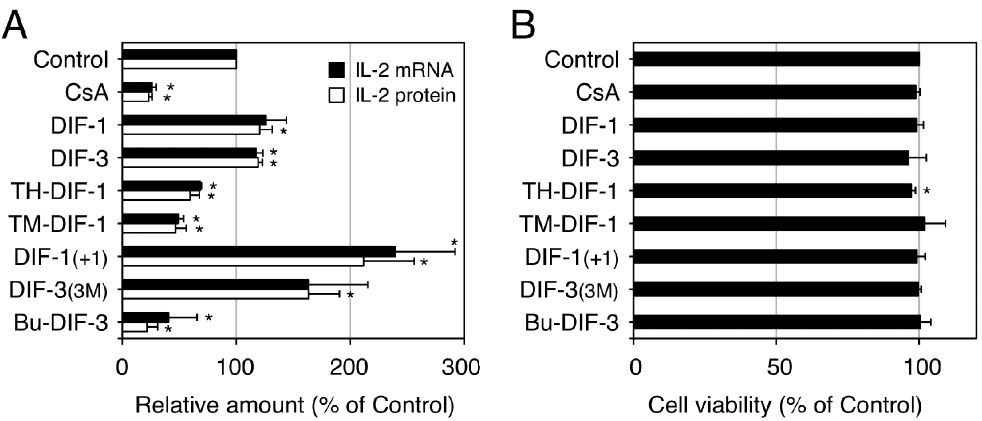
Figure 7. Effects of DIFs on ConA-induced IL-2 production in human Jurkat T cells. Jurkat T cells were pre-incubated at 37 ◦ C for 0.5 h in the presence of 0.1% EtOH (vehicle; Control), 1 µ M cyclosporin A (CsA), or 5 µ M of one of the DIF derivatives. After the addition of ConA (as a mitogen), the cells were further incubated at 37 ◦ C for 3 h and assayed for IL-2 mRNA expression ( A ), whereas another set of cells were incubated for 12 h ( A , B ) and assayed for IL-2 protein secretion ( A ) and for viability by using an MTT assay ( B ). The means and SD (bars) of three independent experiments are shown (adapted from Takahashi et al. [89]). * p < 0.05 versus Control (by t -test; two-tailed, unpaired). ConA-induced IL-2 production was significantly suppressed by the known immunosuppressive drug, CsA and by TH-DIF-1, TM-DIF-1 and Bu-DIF-3 but it was significantly promoted by DIF-1 (+1) and DIF-3 (3M) ; cell viability at 12 h was not affected by any of the compounds, except for TH ‐ DIF ‐ 1.